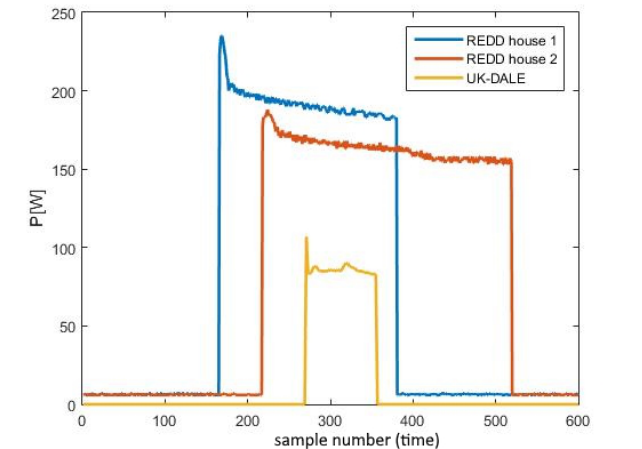
Figure 4. Comparison between the refrigerator’s individual consumption measurements from the REDD and UK-DALE